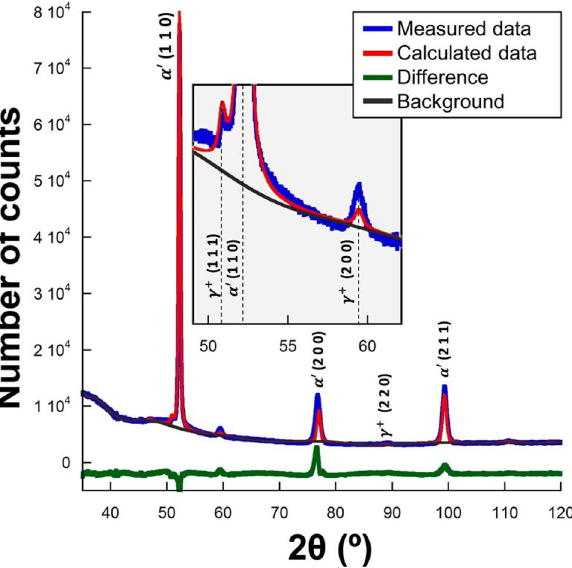
Figure 1. Example of measured XRD diffractogram (blue) obtained for the EOS—40 μm—CW laser condition, where peaks of martensite α ′ and retained austenite γ + are identified. The diffractogram calculated by the Rietveld method without texture correction is shown in red, where the difference of this calculated diffractogram with respect to the measured one is shown in green and the background is shown in